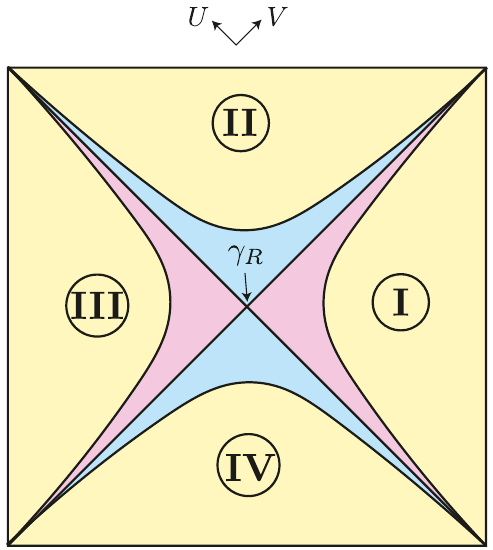
Figure 6 . The Lorentzian spacetime can be divided into four wedges with respect to the HRT surface γ R labelled I-IV. The power series expansion we propose is valid in the regions shaded pink and blue. The solution in the pink region is obtained by analytically continuing the Euclidean solution. The solution in the blue region is obtained by a simple transformation of the analytically continued